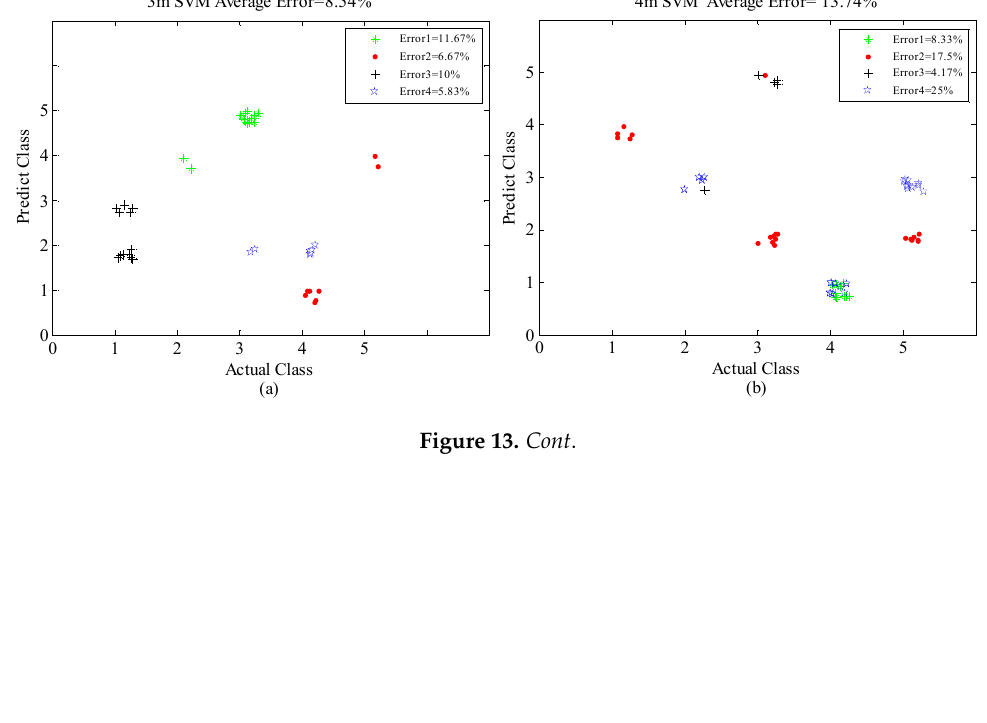
Figure 13. Four-fold cross-validation error distributions of proposed method at different positions: ( a ) 3 m, ( b ) 4 m, ( c ) 5 m, and ( d ) 6 m. 5. Conclusions In this paper, we first selected SFCW UWB radar to conduct the through-wall detection of six common finer-grained human activities according to actual detection environments that would be encountered in applications such as anti-terrorism activities and security. We then introduced a comprehensive range-accumulation time-frequency transform (CRATFR) method based on an inverse weight coefficient according to the characteristics of the finer-grained human activity signals detected by the SFCW radar. This method can make full use of the time-frequency information of different range bins of the UWB radar signal, so as to enhance the micro-Doppler time-frequency spectral features of the finer-grained human activities. The results indicate that different activities show obvious feature differences in their time-frequency spectra. After the time-frequency analysis of human activities, we classified the different motions by extracting eight effective eigenvalues from the spectra resulting from the CRATFR analysis and utilizing SVM. At a position 3 m behind a wall, the data classification accuracies for six activities of eight persons were 98.78% and 93.23%, respectively, for the two scenarios defined in this paper. Furthermore, to correct the deficiency wherein conventional SVM will easily misjudge activities at different through-wall ranges, this paper proposed a novel classification method, the optimal self- adaption support vector machine (OS-SVM), based on prior human position information. Accordingly, the model included in the OS-SVM better captures the time-frequency features of actual motion signals in the corresponding positions. At the same time, it avoids the misjudgment that easily occurs because of the similarity of the features of different activities in different positions which is caused by the weakening of the Doppler high-frequency signals. Experimentally, within the 6 m range, the average classification accuracy of five activities data of eight subjects is 86.67%, while the recognition accuracy of current common method is only 78.12%. Thus, this research is of great